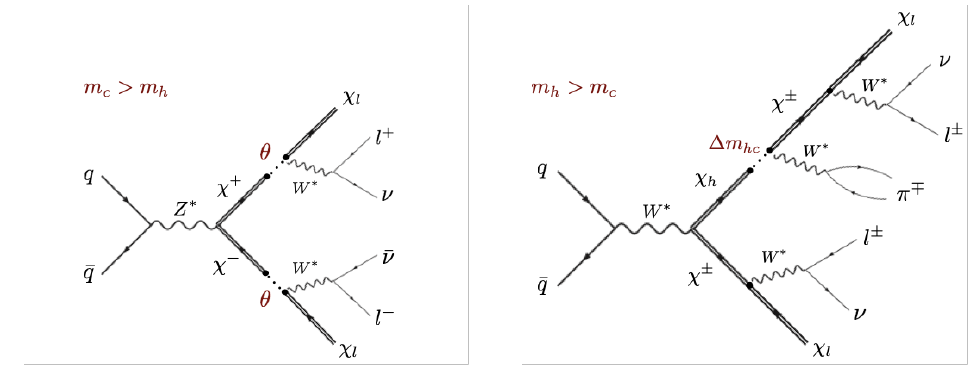
Figure 5 . New signatures of displaced soft leptons (left) and displaced + prompt soft leptons (right) at the